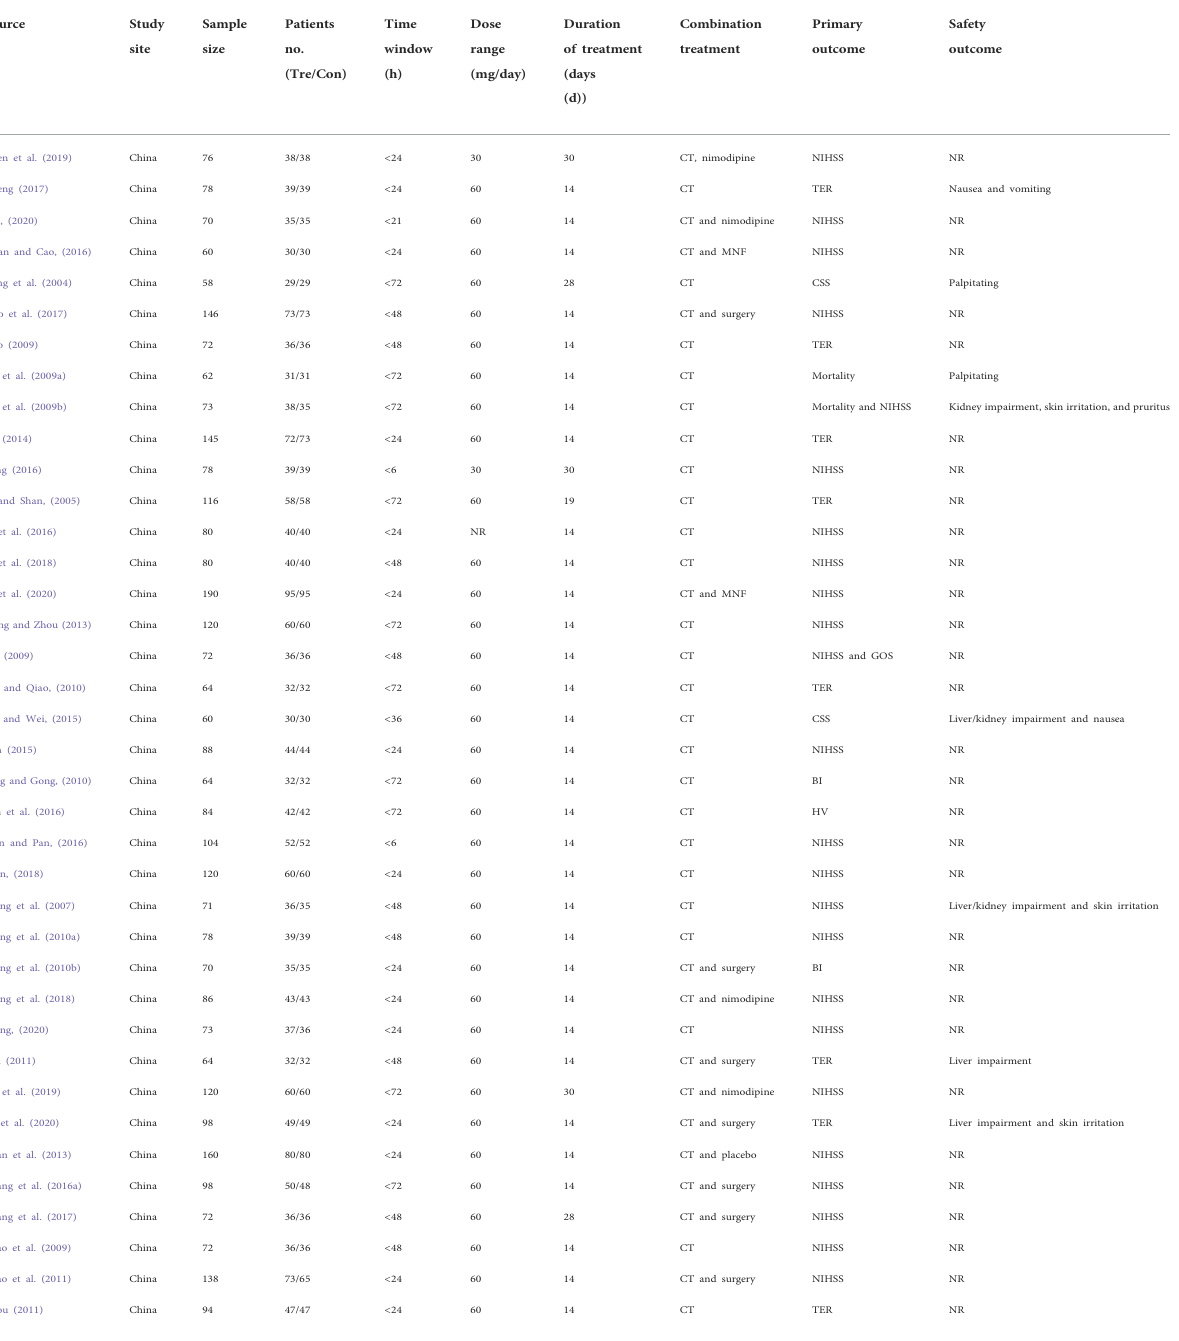
TABLE 1 Characteristics of included studies in the fi nal